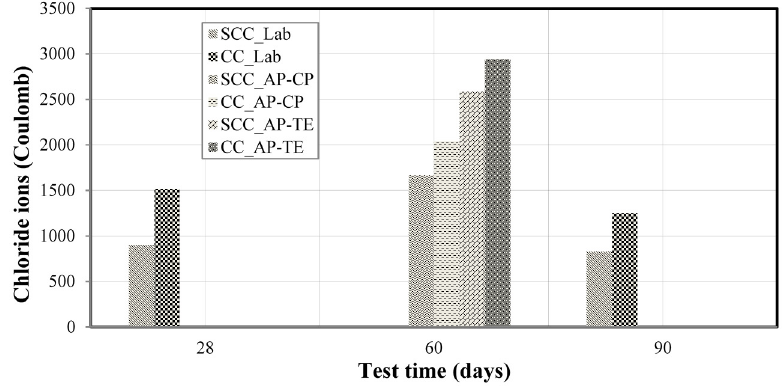
Figure 9. Results of chloride ions diffusion.